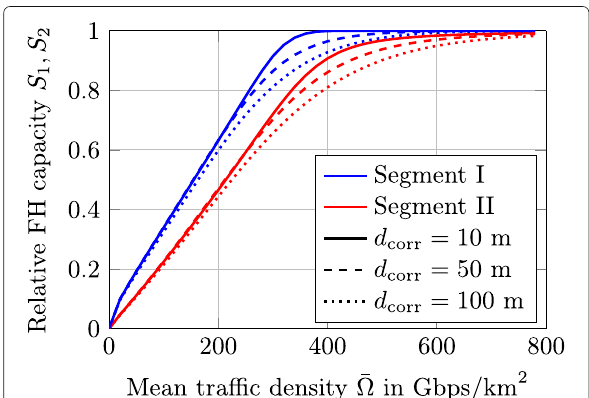
Fig. 9 Impact of traffic correlation. Relative FH capacity for different traffic correlation distances, σ (cid:8) /(cid:8) = 0.5, P O =